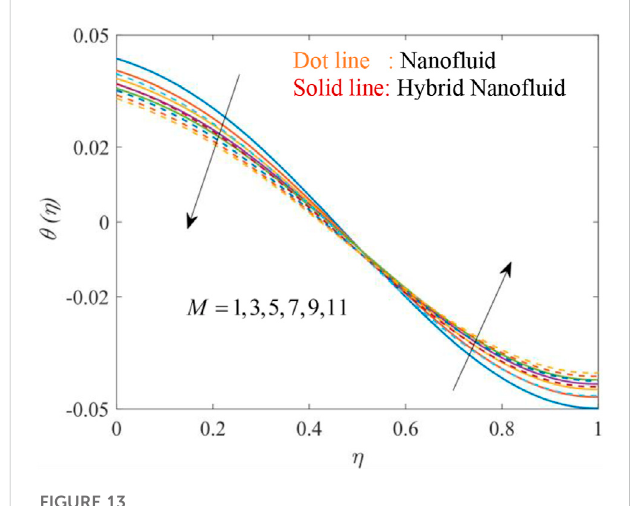
FIGURE 11 Effect of nanoparticles volume fraction φ on g ( η ) .